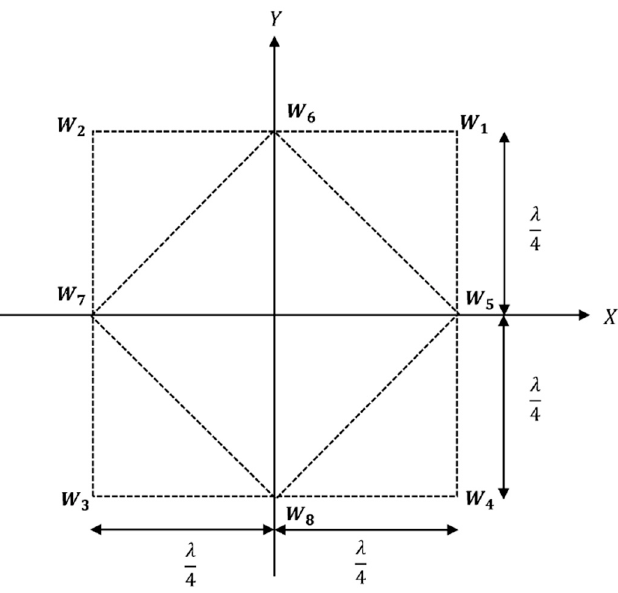
Figure 4. Schematic Diagram of the Proposed Two-Square Configuration 1.